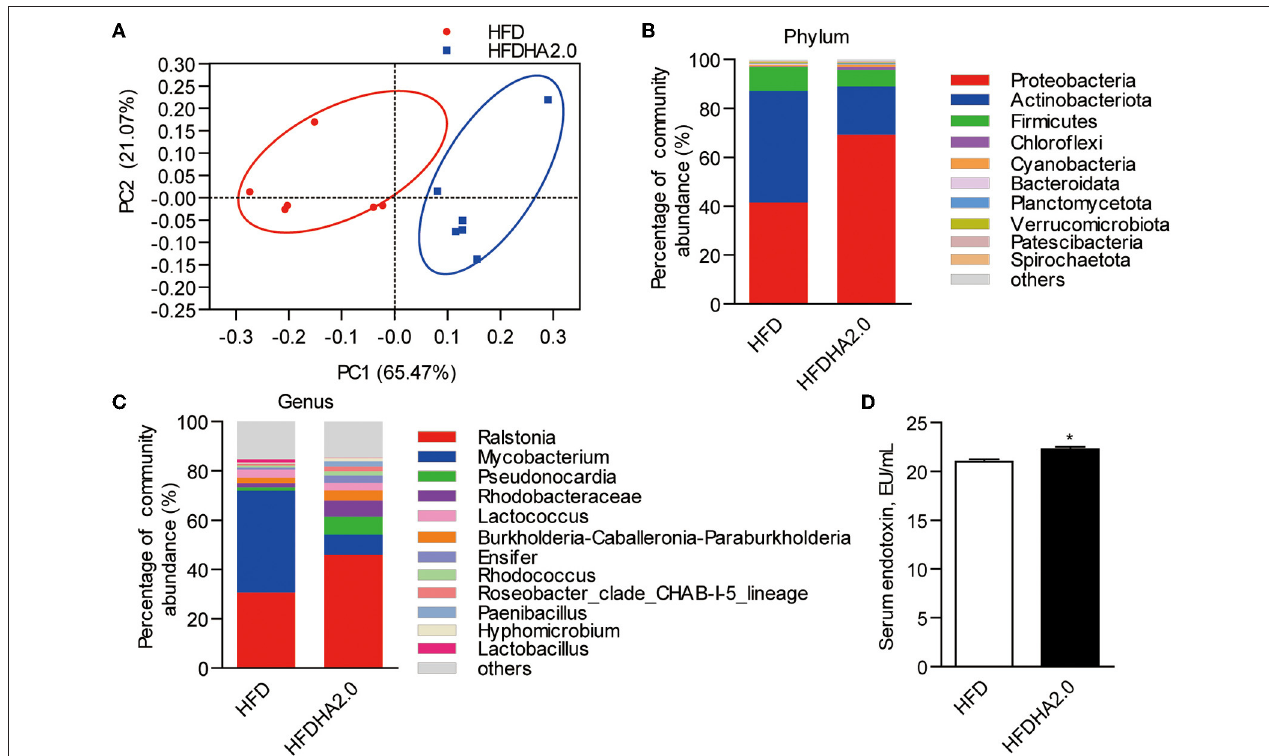
FIGURE 5 | The effects of DHA supplementation on gut microbial community in zebrafish. (A) PCoA analysis of gut microbiota in HFD- or HFDHA2.0-fed zebrafish. (B) Relative abundance at the phylum level of gut microbial community from HFD- or HFDHA2.0-fed zebrafish. (C) Relative abundance at the genus level of gut microbial community from HFD- or HFDHA2.0-fed zebrafish. (D) Serum endotoxin in HFD- or HFDHA2.0-fed zebrafish. The values are means ± SEMs ( n = 4 or 6 biological replicates). * p < 0.05. HFD, high-fat diet; HFDHA2.0, 2% DHA-supplemented HFD.